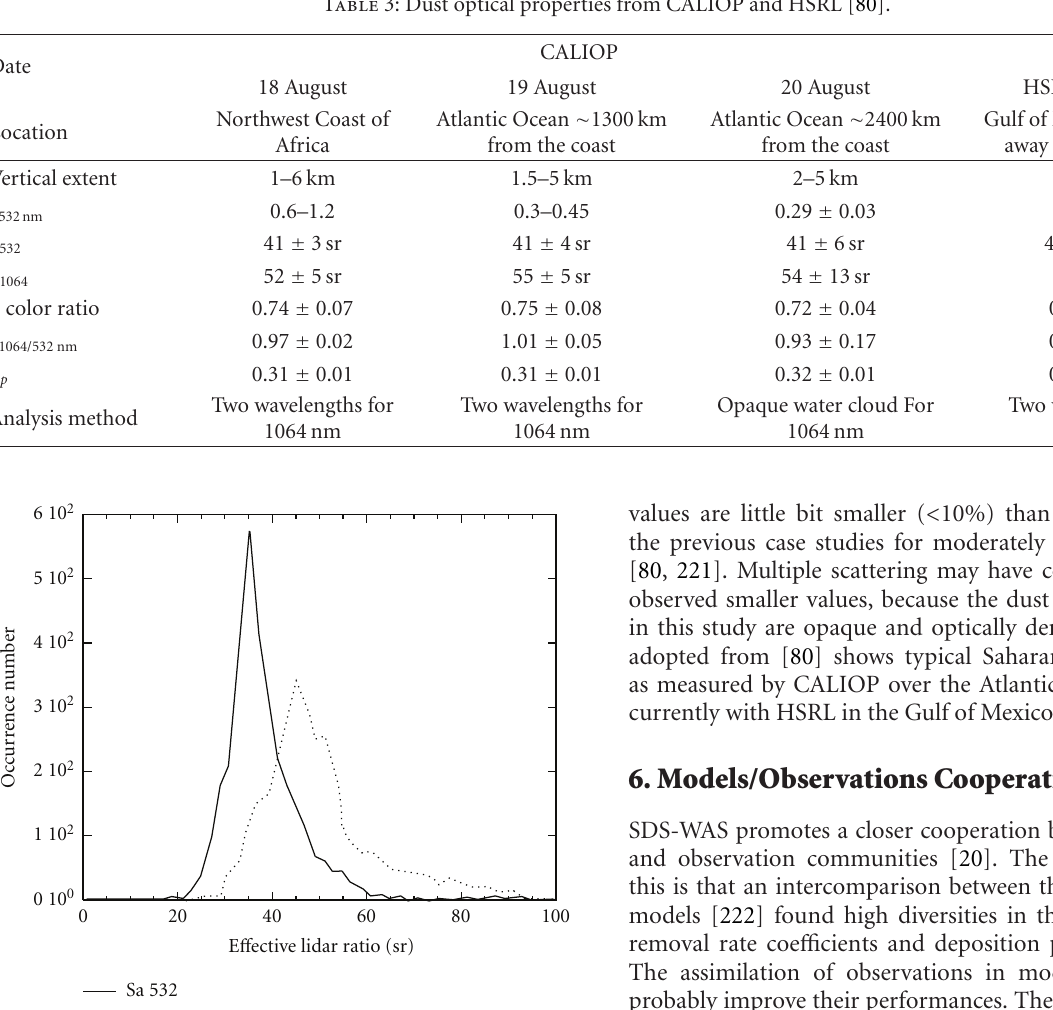
Table 3: Dust optical properties from CALIOP and HSRL [80].